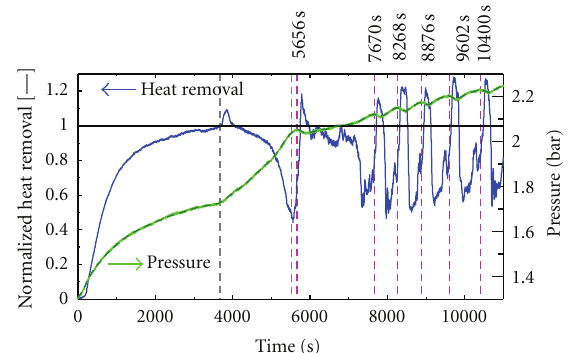
Figure 17: Normalized heat removal together with pressure trace for test ST4